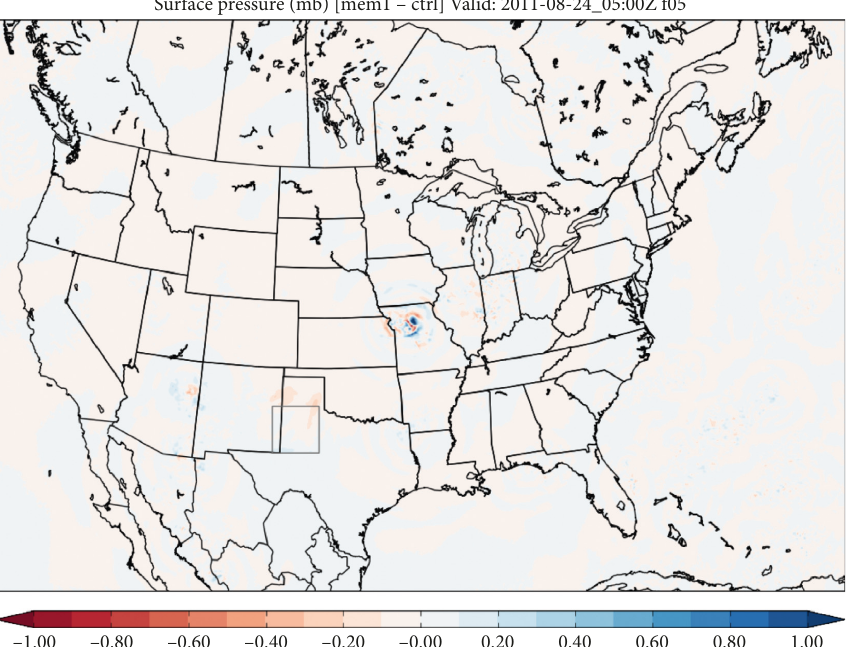
Figure 5: Differences in surface pressure at forecast hour 05 between a wind farm run and a control run without any wind farms. Wind farms in box are centered over western Texas.